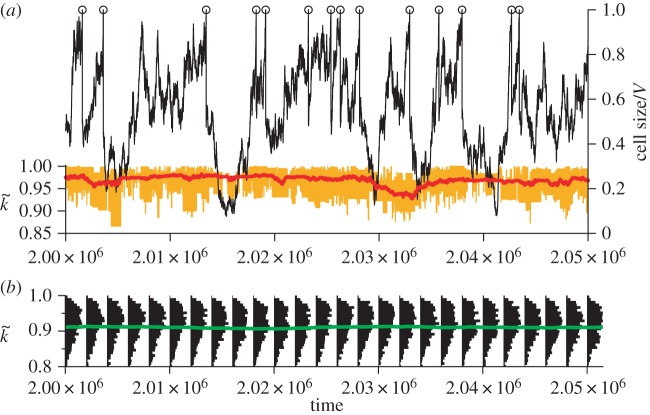
No evolutionary oscillation in the absence of conflicting multilevel evolution. (a) The dynamics of a protocell lineage along its line of descent for V = 316. The displayed lineage refers to the common ancestors of a population at time 2.5×106. Colour coding as in figure 2b. (b) The frequency distributions of  (black), and its average  (green) in protocell populations. (Online version in colour.)